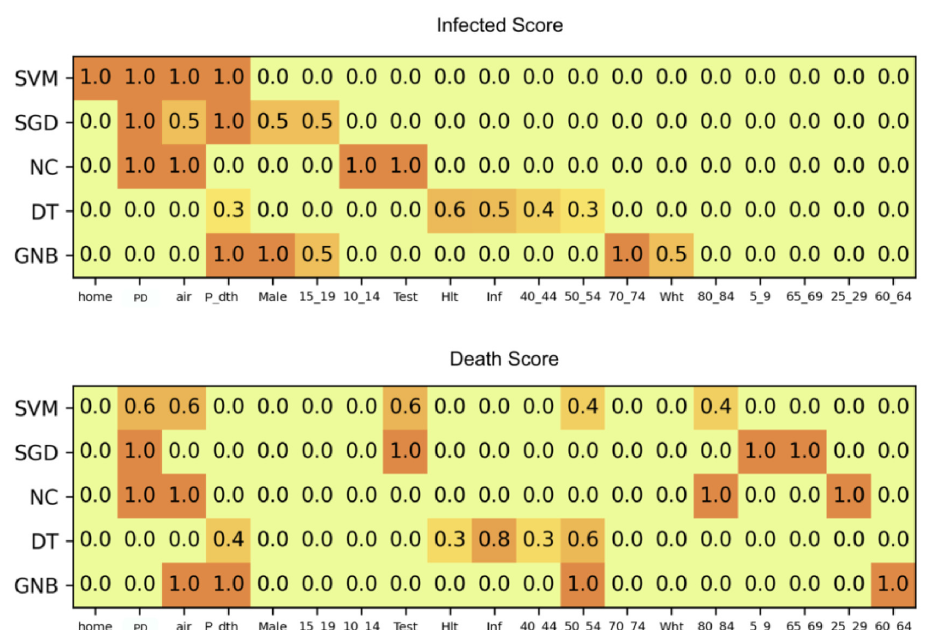
Fig 2. Participation of features in 5-tuples of key feature combinations for infected score (top) and death score (bottom). Refer Table 1 for the feature abbreviations.